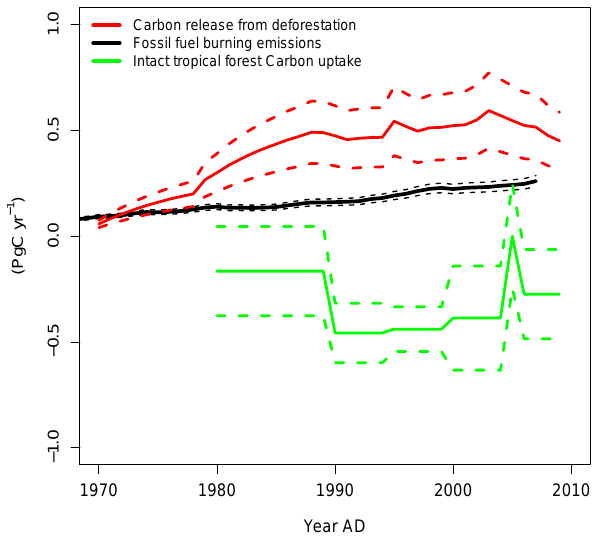
Fig. 9. Flux estimates from South America to the atmosphere (a positive value indicates a flux to the atmosphere) due to deforesta- tion and a simplified book-keeping model, fossil fuel burning and carbon uptake by intact tropical